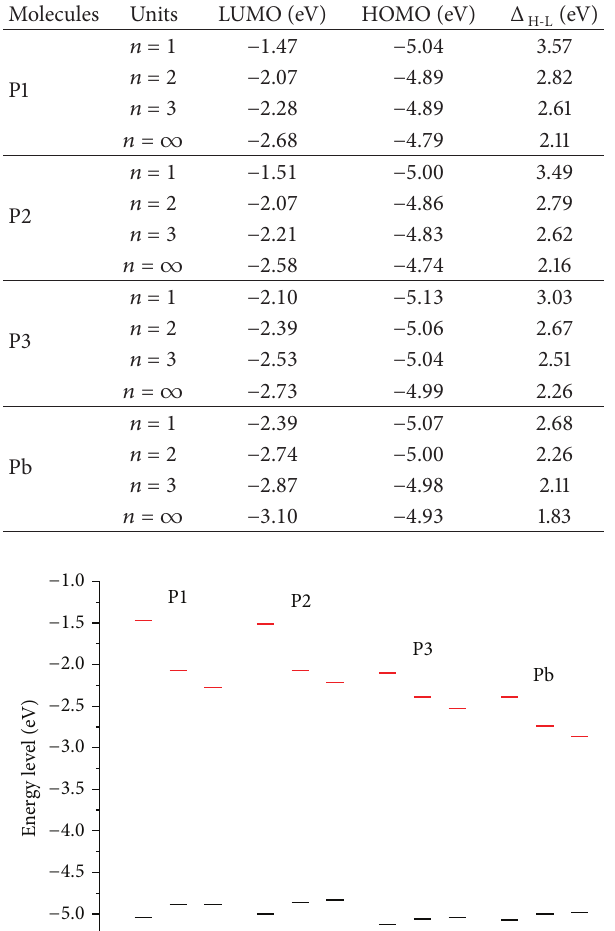
Table 2: Energy levels of HOMO and LUMO and energy gaps Δ of P1, P2, P3, and PBDT-BTA (Pb). Molecules